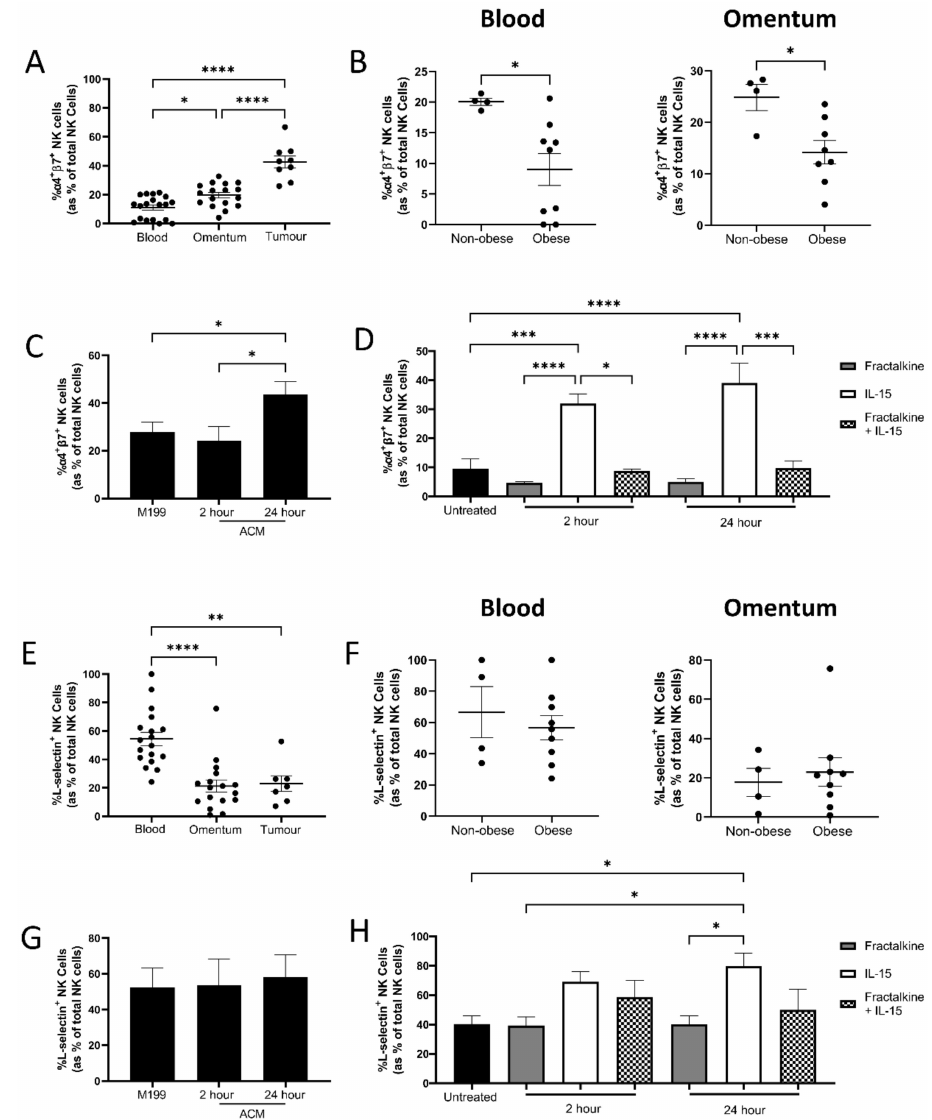
Figure 4. Fractalkine attenuates IL-15 induced expression of gut-homing integrins α 4 β 7. ( A ) Dot plot showing the frequencies of α 4 + β 7 + NK cells as a percentage of total NK cells in OAC patient derived blood ( n = 18), omentum ( n = 17) and tumour ( n = 9). ( B ) Dot plot showing the frequencies of α 4 + β 7 + NK cells as a percentage of total NK cells in OAC patient derived blood divided in to obese ( n = 8-9) and non-obese ( n = 4) by VFA in blood (left) and omentum (right). ( C) Bar chart showing the frequencies of α 4 + β 7 + NK cells following treatment with M199 or OAC patient derived adipose conditioned media for 2 and 24 h. ( D) Bar chart showing the frequencies of α 4 + β 7 + NK cells following no treatment (untreated) or treatment with 30 ng/mL fractalkine and/or 100 ng/mL IL-15 for 2 or 24 h ( n = 3–14). ( E ) Dot plot showing the frequencies of L-selectin + NK cells as a percentage of total NK cells in OAC patient derived blood ( n = 18), omentum ( n = 17) and tumour ( n = 8). ( F ) Dot plot showing the frequencies of L-selectin + NK cells as a percentage of total NK cells in OAC patient derived blood divided in to obese ( n = 9) and non-obese ( n = 4) by VFA in blood (left) and omentum (right). ( G ) Bar chart showing the frequencies of L-selectin + NK cells following treatment with M199 or OAC patient derived adipose conditioned media for 2 and 24 h. ( H ) Bar chart showing the frequencies of L-selectin + NK cells following no treatment (untreated) or treatment with 30 ng/mL fractalkine and/or 100 ng/mL IL-15 for 2 or 24 h ( n = 3–14). One way ANOVA or t -test as appropriate, * p < 0.05, ** p < 0.01, *** p < 0.001, **** p <